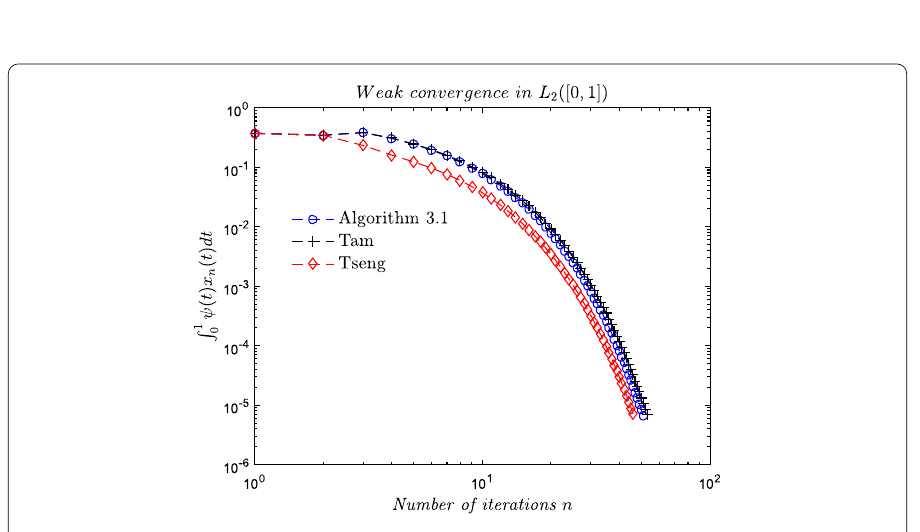
Figure 5 Example 2 with θ = 0.4 and λ n = 0.1250 + (0.0156) n